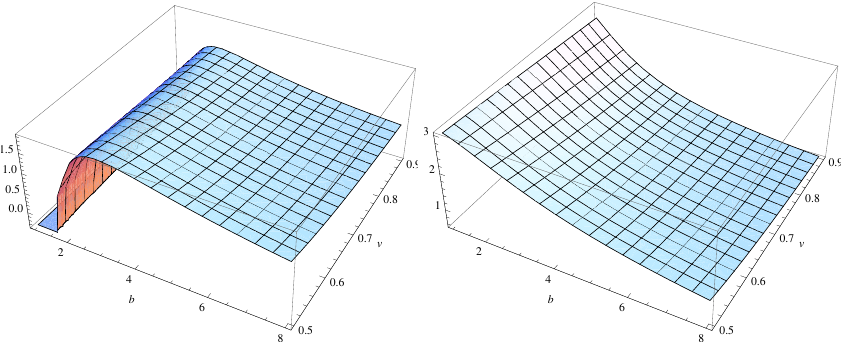
Figure 11. ( left ) The variation in total deflection 2 (cid:101) ( 0 ) at φ = 0 is shown with respect to b and v . ( right ) Total deflection 2 (cid:101) ( 0 ) at φ = 0 is shown with respect to b and v , for Schwarzschild case.